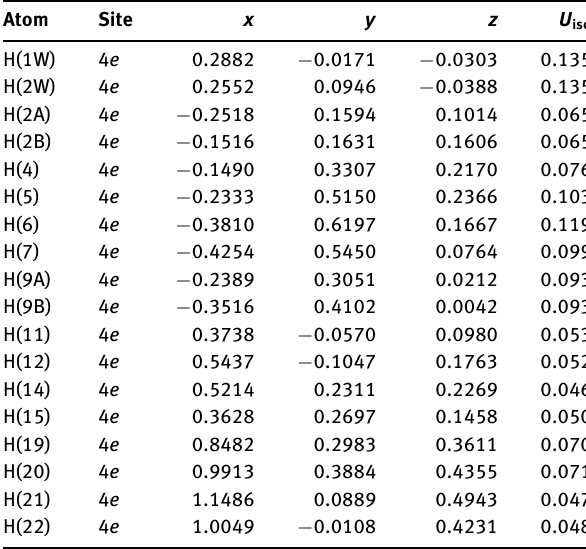
Table 2: Fractional atomic coordinates and isotropic or equivalent isotropic displacement parameters (Å 2